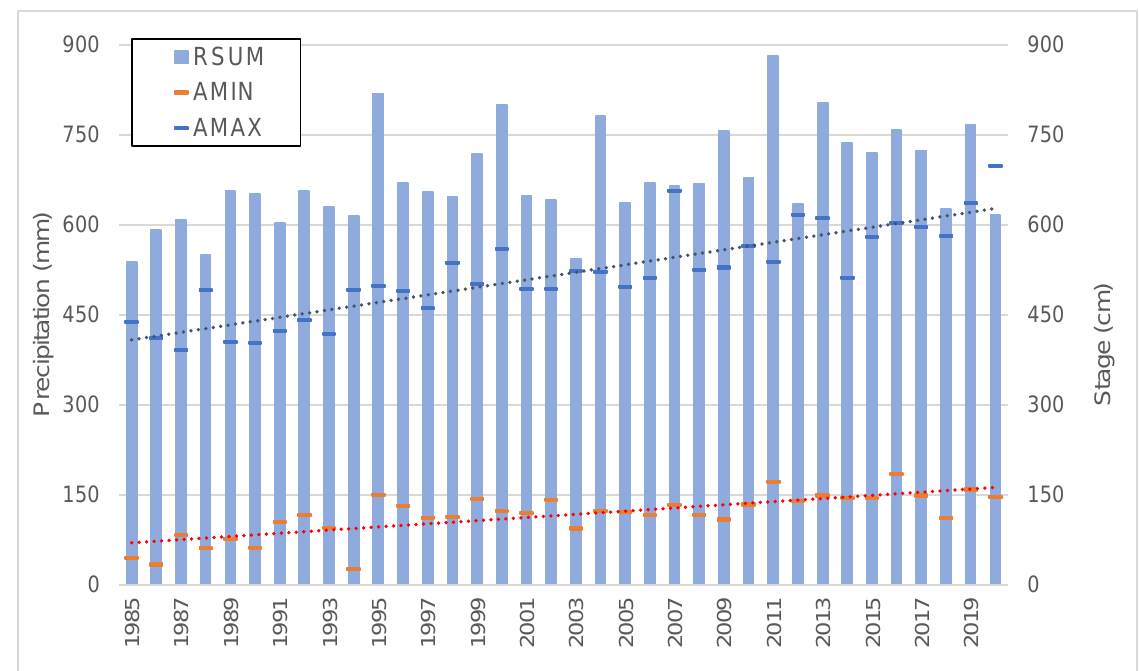
Water 2021 , 13 , x FOR PEER REVIEW Figure A2. Trends of AMAX (h), AMIN (h) and annual precipitation (R SUM ) over the whole Niger River Basin (1985–2020).